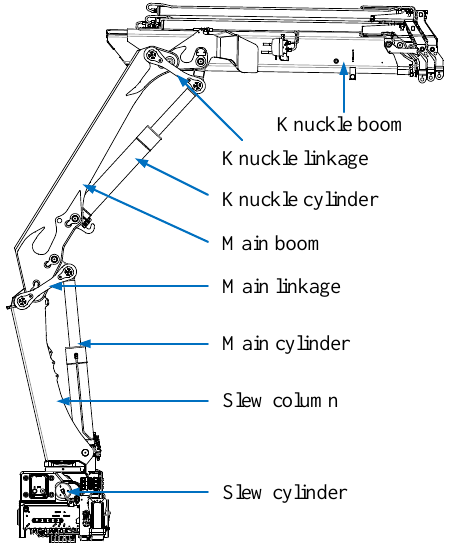
Figure 4. Illustration of the HMF 2020K4 loader